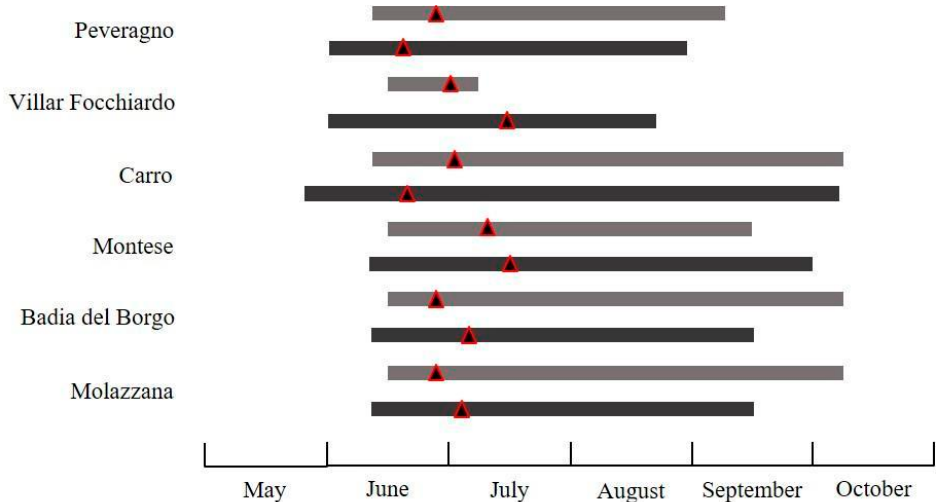
Figure 3. Seasonal flight activity of Pammene fasciana (L.) recorded in the surveyed sites using the commercially available pheromone (grey bars refer to 2018, black bars to 2019. For each bar, the triangle corresponds to the population peak).